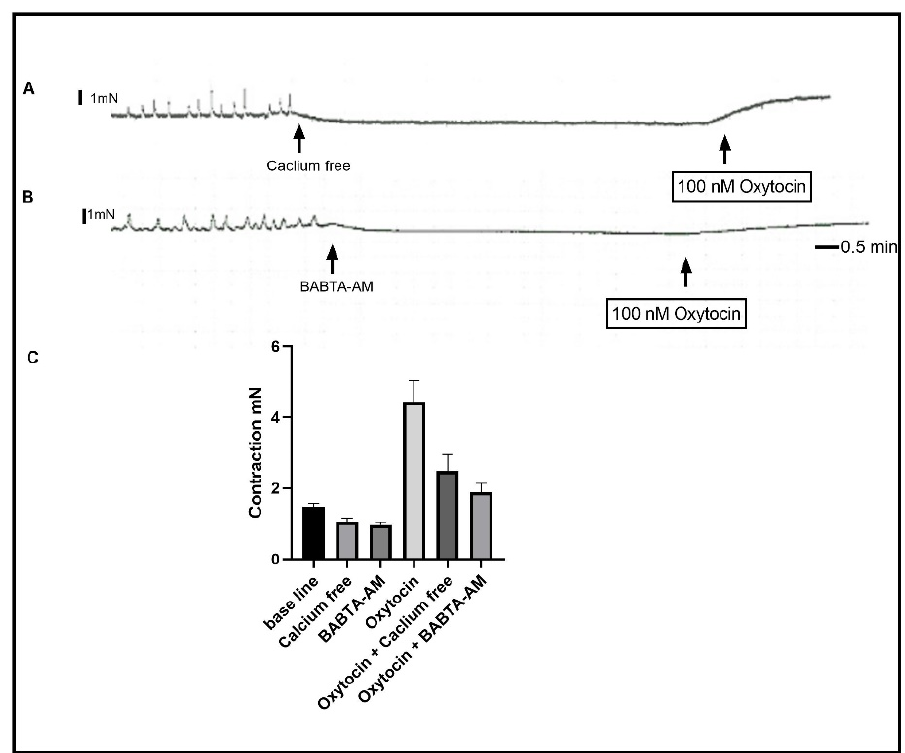
Figure 5. Effect of calcium-free Krebs buffer and chelating cytosolic calcium on oxytocin-induced contraction. ( A ) is a representative trace illustrating oxytocin-induced contraction in calcium-free Krebs buffer. ( B ) is a representative trace illustrating oxytocin-induced contraction in the presence of 10 µM of BABTA-AM. ( C ) is a summary graph showing that oxytocin-induced contraction is significantly inhibited by removing extracellular and intracellular calcium. Data expression is in mN of force. Values are mean ± SEM. n = 6.